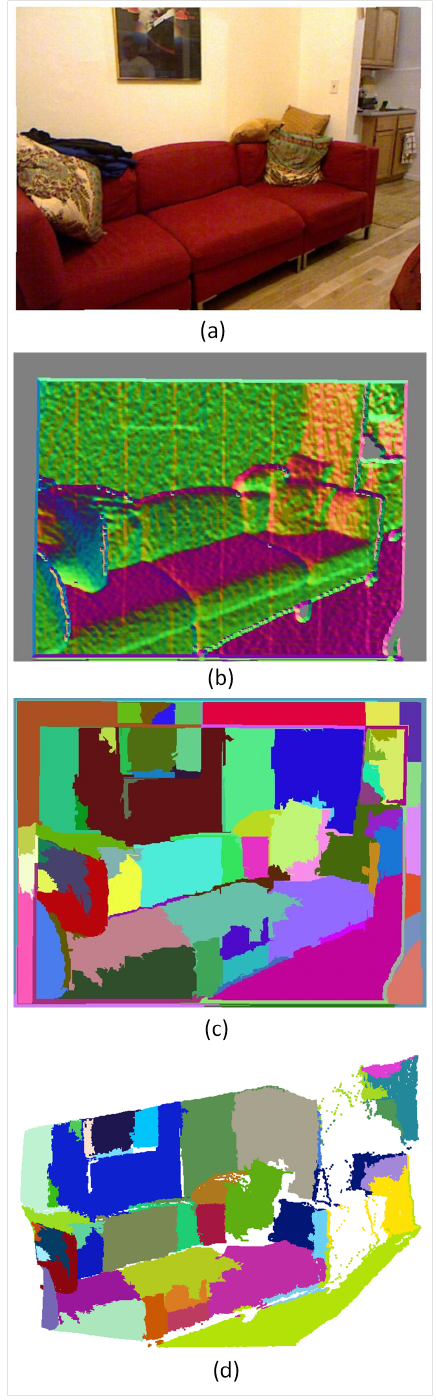
Figure 1: 3D patches: (a) input color image, (b) normal map, (c) superpixel segmentation and (d) a snapshot of the 3D point cloud with labeled patches.